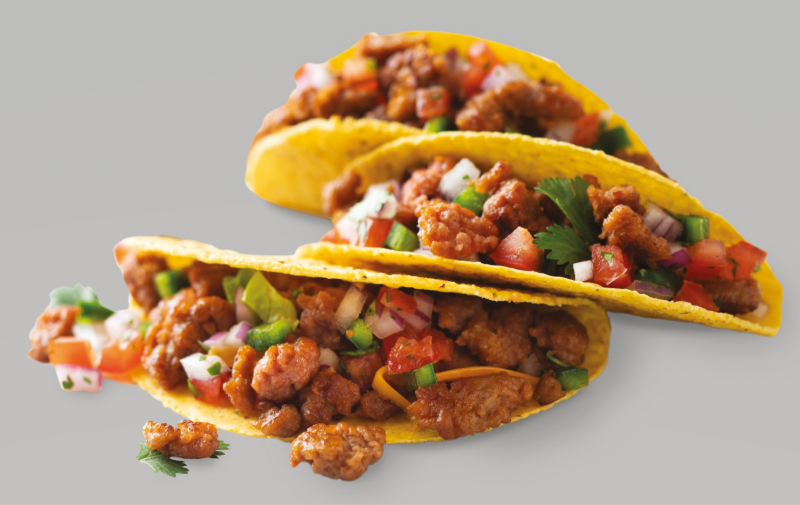
Plant-based grind.